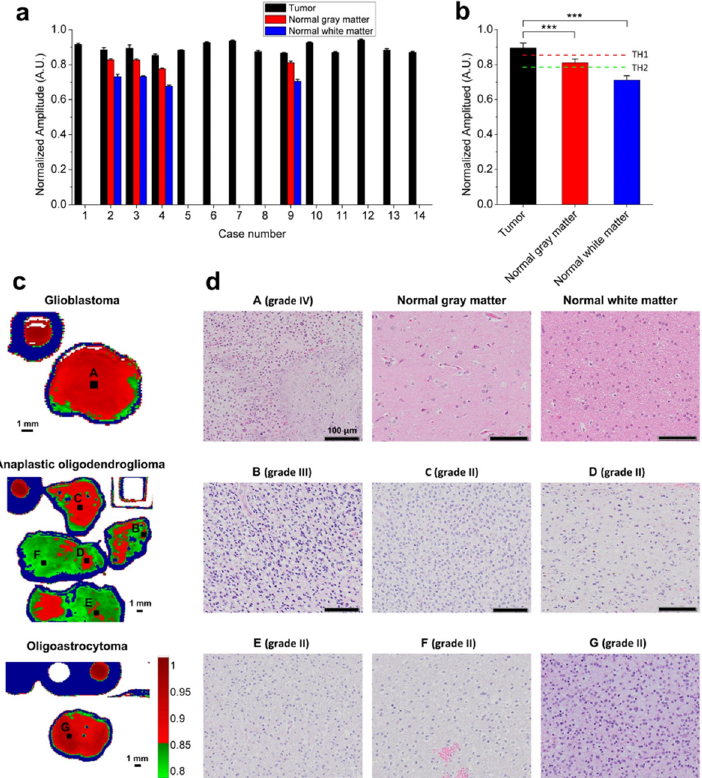
Figure 9. Discrimination of low- and high-grade human gliomas ex-vivo with TRI. ( a ) Terahertz parameter (TP) values from regions of interest (ROIs) in tumors, normal gray matter, and white matter. ( b ) Quantification of threshold value 1 (TH1) and TH2 (dashed red and green lines, respectively) for tumor discrimination using the data shown in ( a ), *** P < 0.001. Representative cases of grade IV, III, and II gliomas, characterized by ( c ) TRI and ( d ) H&E stained images. Red regions indicate regions with a TP value over TH1. The capitals A–G shown in ( d ) correspond to the ROIs in ( c ). Adapted from [158].